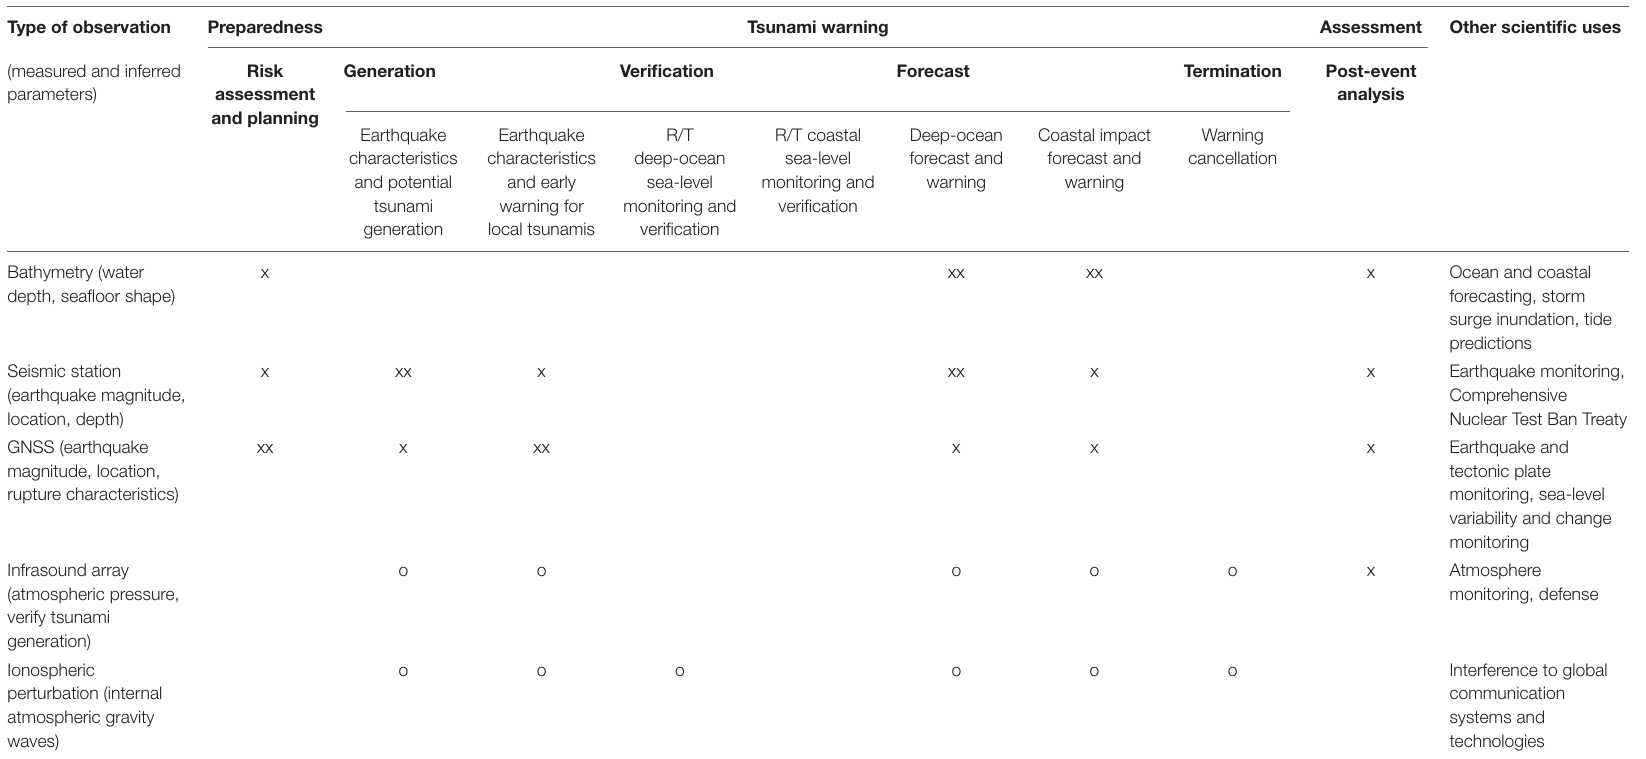
TABLE 1A | Observation utility matrix: Geophysical and atmospheric measurements. Type of observation (measured and inferred